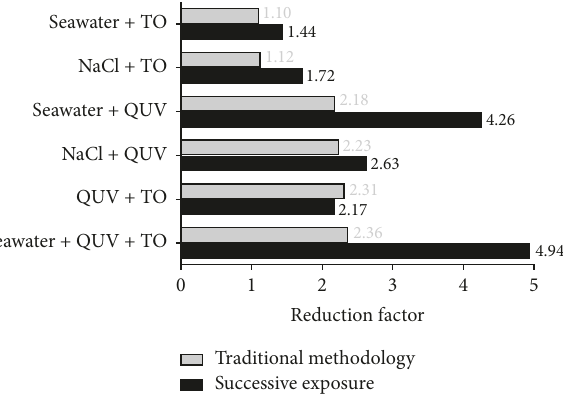
Figure 2: Comparison of the reduction factors obtained by the traditional methodology and by the successive exposure to the degradation